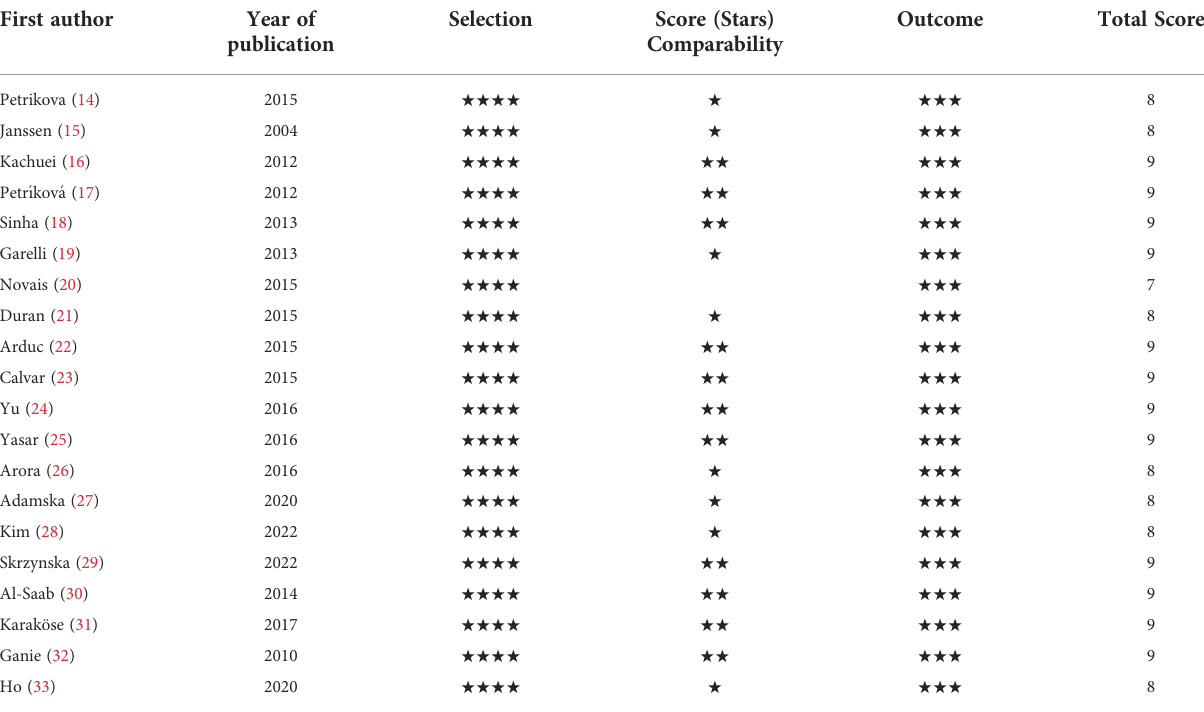
TABLE 2 Newcastle-Ottawa Scale for assessing the quality of nonrandomized studies.